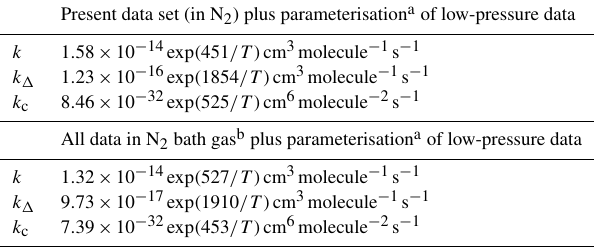
Table 1. Parameters for calculation of k 5 using Eq. (3).